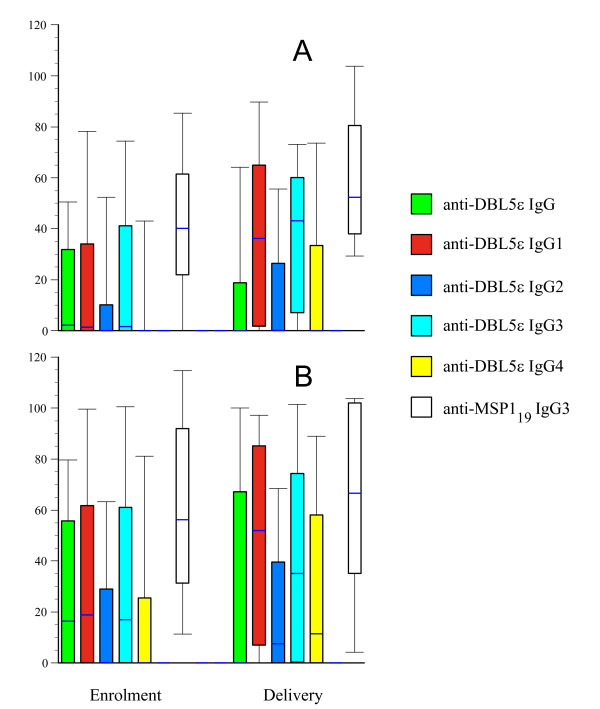
Parity-dependency of the plasma antibody reactivity to VAR2CSA and MSP119 recombinant proteins. ELISA was carried out on DBL5ε- and MSP119 coated plates. IgG, IgG1, IgG2, IgG3, and IgG4 directed against DBL5ε-, as well as against MSP119 . Antibody plasma levels are expressed as arbitrary units (AU) and are shown at enrolment and at delivery for primigravid (panel A, n = 53) and multigravid women (panel B, n = 185) from Senegal. The top, bottom, and line through the middle of the box correspond to the 75th percentile, 25th percentile, and 50th percentile (median), respectively. The whiskers on the bottom extend from the 10th percentile and top 90th percentile.